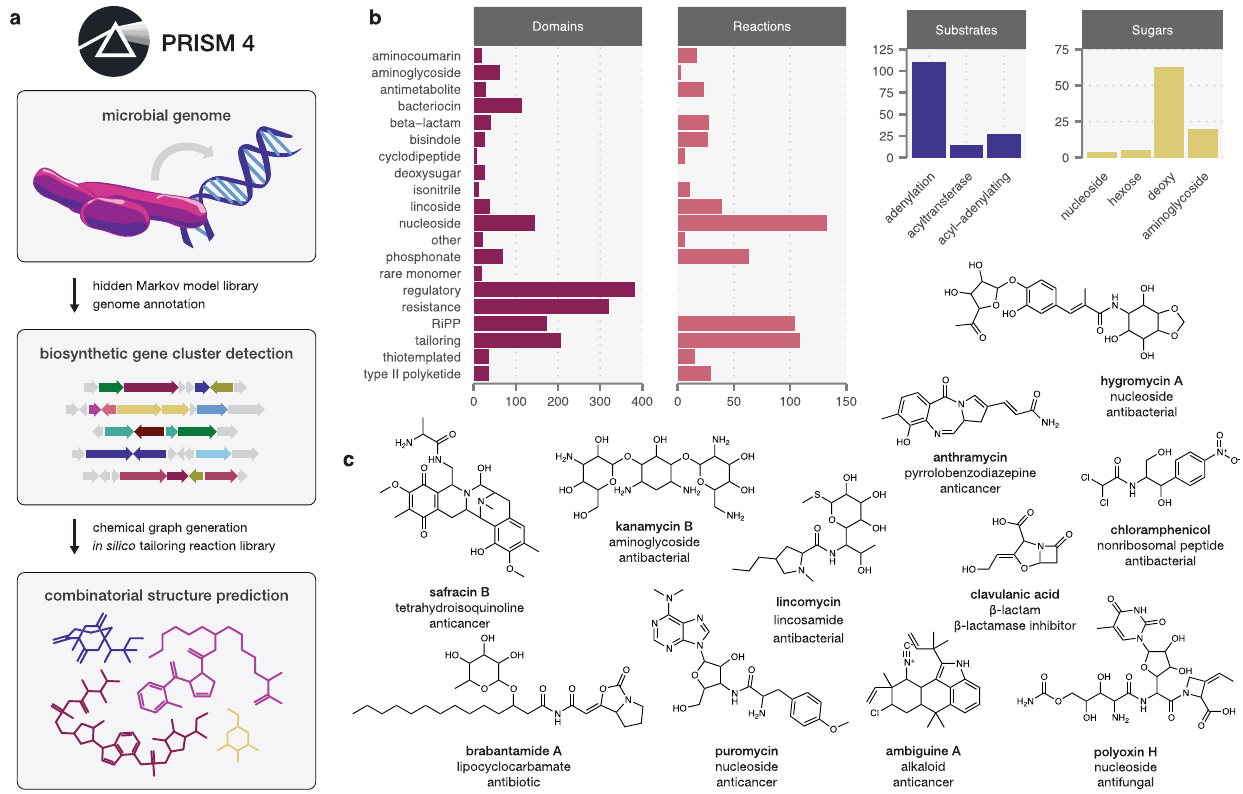
Fig. 1 A comprehensive platform for genome-guided prediction of secondary metabolite chemical structures. a Schematic overview of PRISM 4. Microbial genome sequences are annotated using a library of 1,772 HMMs, and secondary metabolite BGCs are identi fi ed using a rule-based approach. Combinatorial, graph-based chemical structure prediction is effected using a library of 618 virtual tailoring reactions. b Total number of HMMs, virtual tailoring reactions, substrates, and sugars incorporated in PRISM 4. c Examples of predicted chemical structures generated by PRISM 4 for newly added families of secondary metabolites. Source data are provided as a Source Data fi